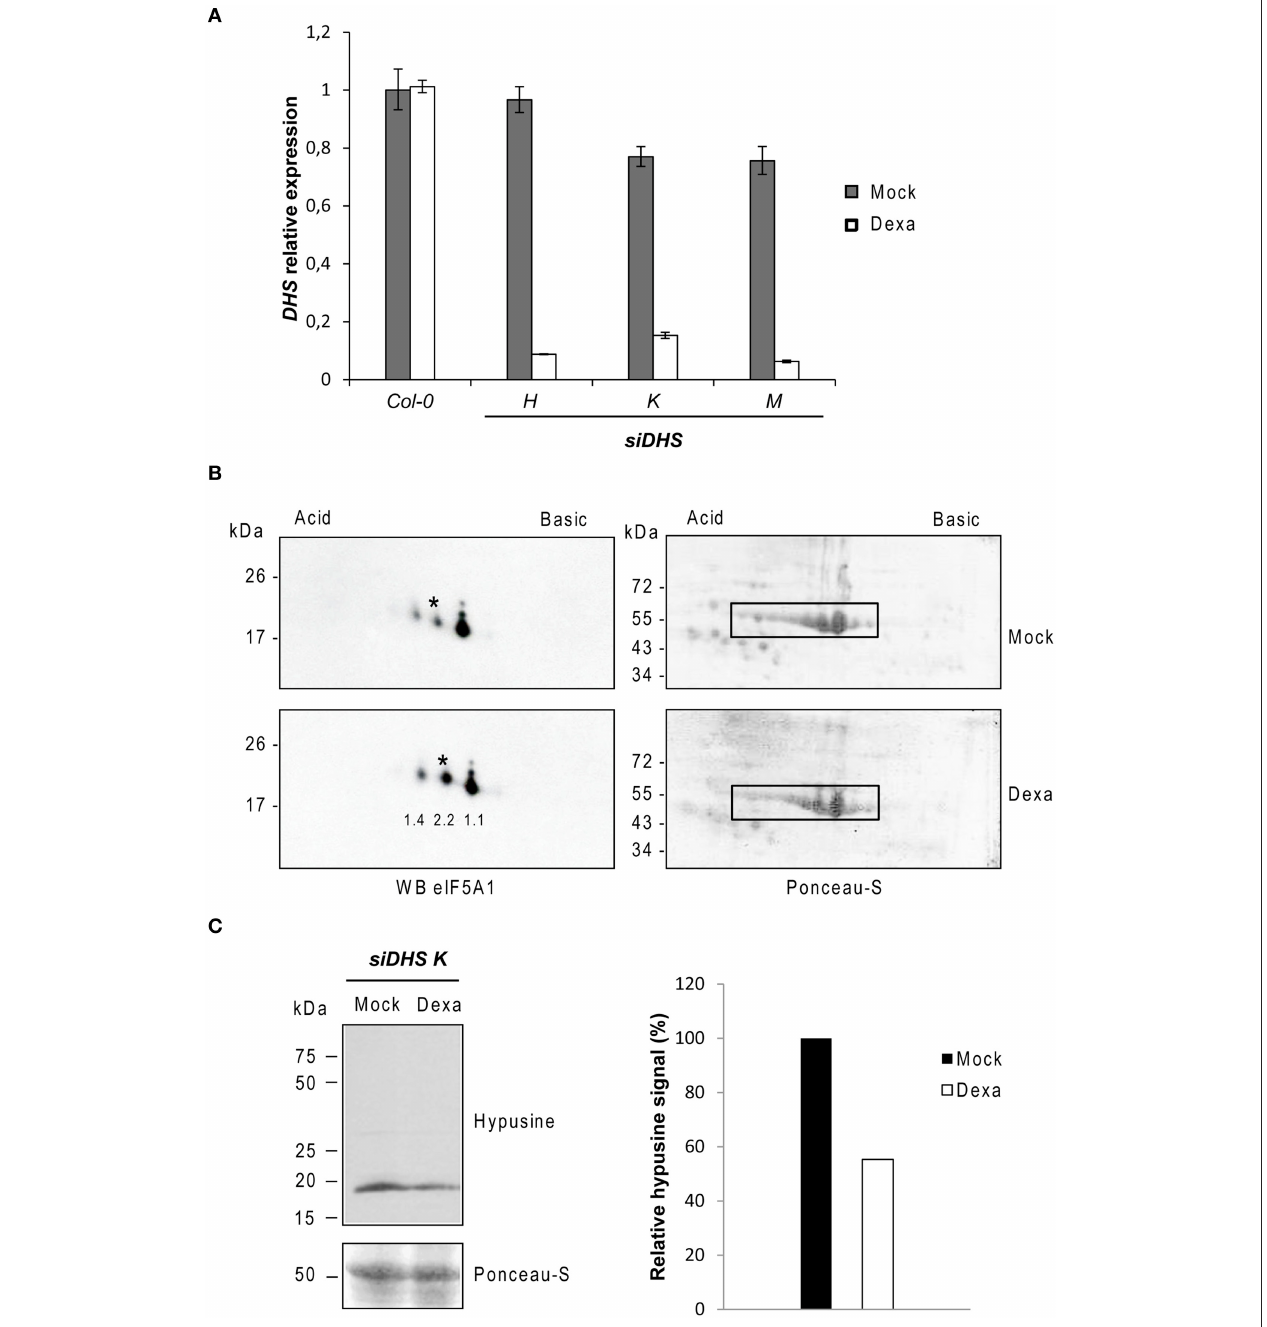
FIGURE 1 | Molecular characterization of siDHS transgenic plants for conditional DHS silencing. (A) DHS gene expression relative to the mock Col-0 sample was carried out by RTqPCR with 10-day-old plant seedlings treated with (dexa) or without (mock) dexamethasone. Error bars represent standard deviation from three independent technical replicates. (B) 2D-electrophoresis/western blot analysis with anti-eIF5A1 antibody (left panels) was performed with the same amount of 35 µ g total protein as shown by Ponceau staining (right panels) from plant seedlings treated or not with dexamethasone. The western blots represent a typical result of three independent biological replicates. Asterisks indicate the non-hypusinated eIF5A1 proteoform. The numbers below each spot on the immunoblot of the Dexa panel indicate the fold-change increase for every spot quantified by ImageJ analysis relative to the Mock panel. Both Dexa and Mock values were previously normalized to the Rubisco signals highlighted with a rectangle in their respective Ponceau staining panel. (C) On the left, SDS-PAGE/western blot analysis with anti-hypusine antibody is shown in the upper panel and Ponceau staining of the same blot in the lower panel. The bar diagram on the right shows the quantification of hypusine signal that was determined by measuring with ImageJ the band intensity relative to the Ponceau staining of the Rubisco protein in the same lane and plotted relative to the mock sample. The result was confirmed with two different biological replicates.